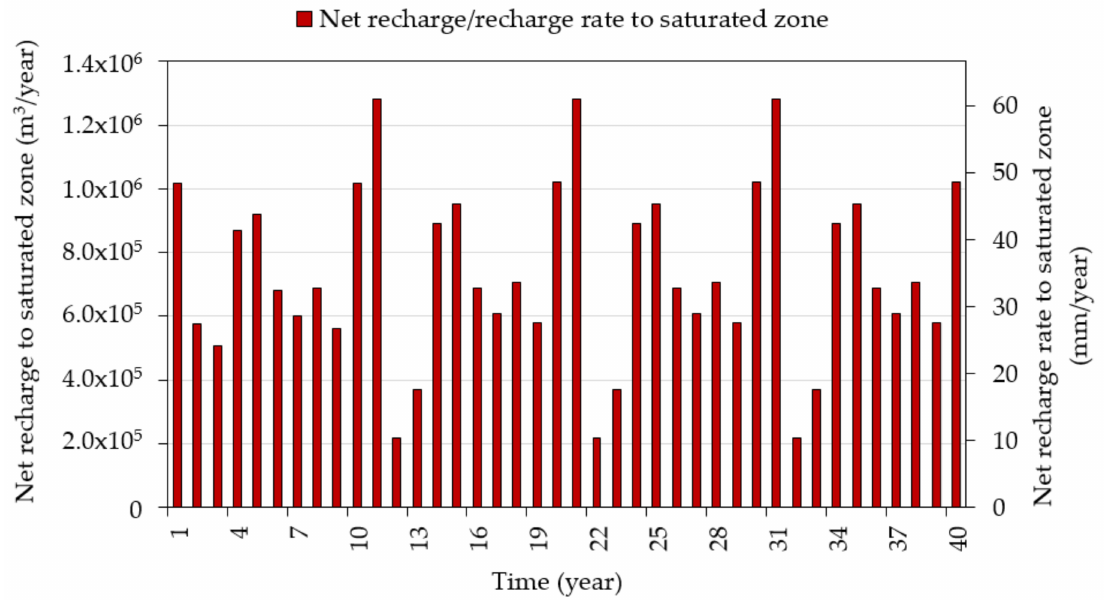
Figure 9. Total net recharge and the net recharge rate between the unsaturated and saturated soil zones in each